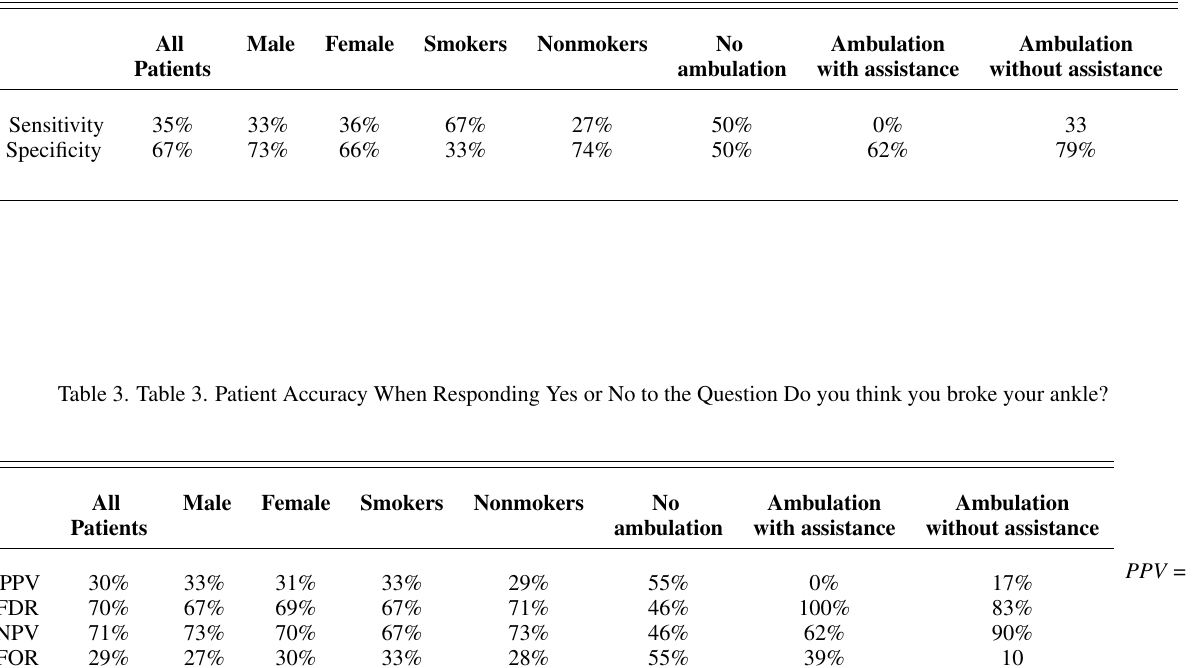
Table 2. Sensitivity and Specificity of Question "Do you think you broke your ankle?" as a screening test